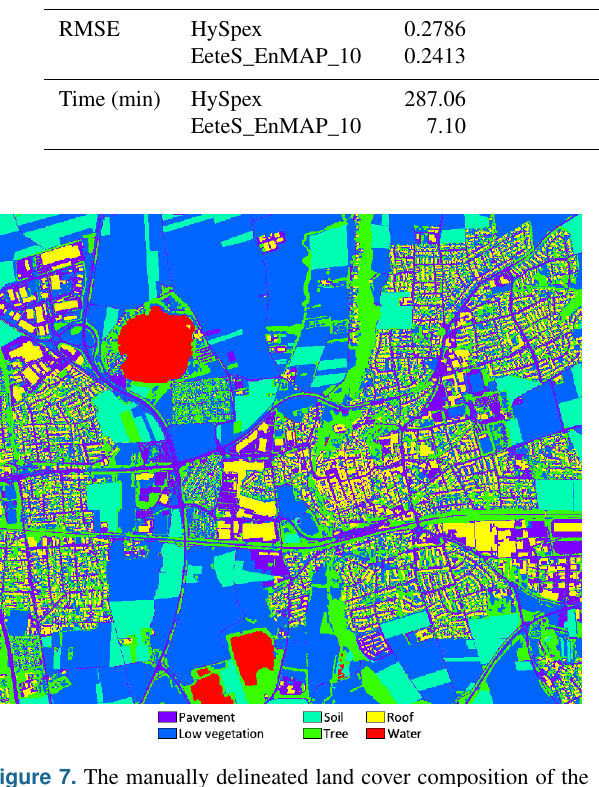
Figure 7. The manually delineated land cover composition of the sub3 region based on the DLR 3K